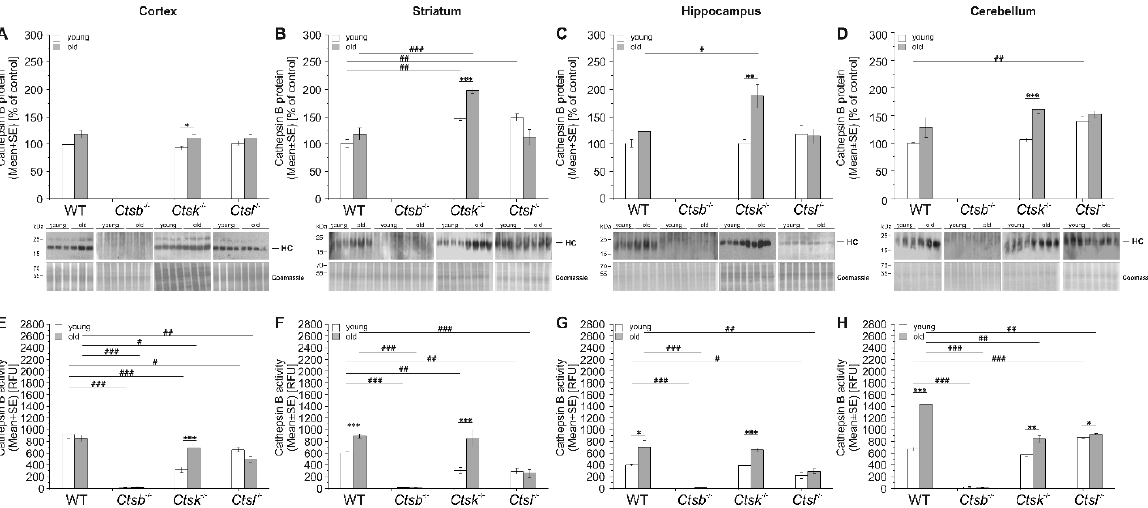
Figure 4. Status of cathepsin B protein and activity levels in the CNS of young and aged cathepsin- deficient mice compared to WT controls. ( A – D ) Densitometry analysis of immunoblots prepared from lysates of cerebral cortex, striatum, hippocampus, and cerebellum of young (white bars) and aged (gray bars) WT, Ctsb − / − , Ctsk − / − , and Ctsl − / − mice as indicated. Representative immunoblots are shown in the lower panels; lanes represent separate individuals. Coomassie-stained gels serve as a loading control. There were age-dependent increases in cathepsin B protein in all brain regions of aged Ctsk − / − animals. ( E – H ) Cathepsin B activity (measured in relative fluorescence units (RFU)), as determined by cleavage of Z-Arg-Arg-AMC at pH 6.0. Cathepsin B activity was increased in all brain regions of aged Ctsk − / − mice, as well as in striatum, hippocampus, and cerebellum of aged WT mice. Levels of significance between different ages are denoted as * or # for p < 0.05; ** or ## for p < 0.01; *** or ### for p < 0.001.